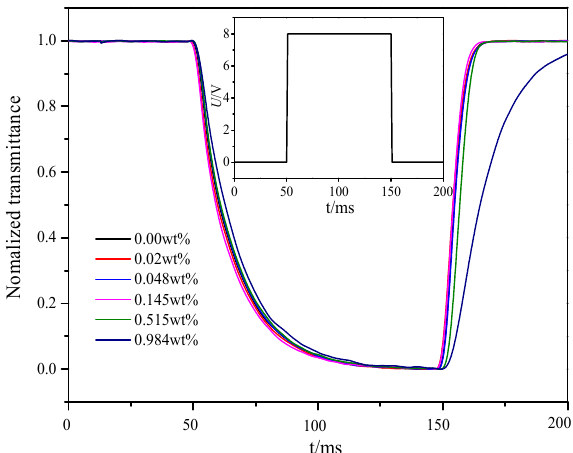
Figure 9. Normalized transmittance versus time of the LC material MAT-09-1284 doped with γ -Fe 2 O 3 nanoparticles for different concentrations in PAN cell. The embedded diagram describes the characteristic of the pulse voltage. The pulse width is 100 ms and the amplitude is 8 V.